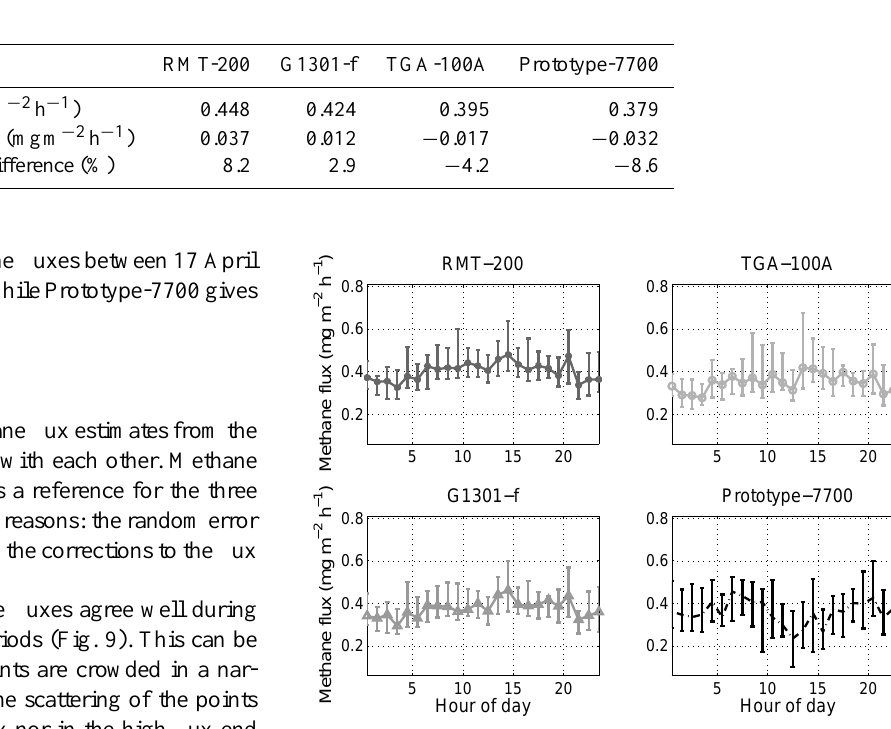
Table 5. Average difference between methane flux obtained from one instrument and mean flux obtained from the four instruments between 17 April and 17 May. All the four methane gas analyzers were working during this period. If difference and relative difference are negative, the flux obtained from that certain instrument is smaller than the mean flux obtained from all of the instruments. Only data flagged with quality flag 0 was used.